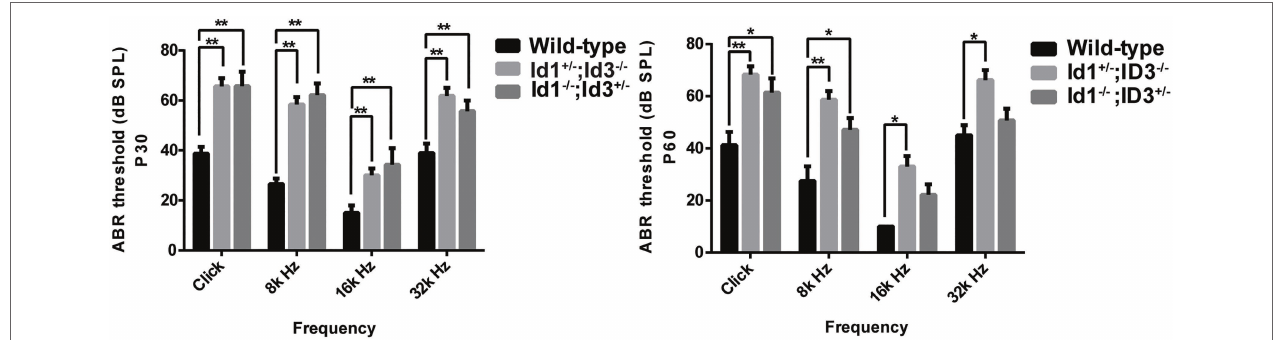
FIGURE 1 | Comparison of the mean auditory brainstem response (ABR) thresholds of right ears from age-matched littermate control mice, Id1 − / − ; Id3 +/ − and Id1 +/ − ; Id3 − / − mice at ages P30 and P60. The results indicated that at P30, the mean ABR thresholds at any stimulus frequencies in the Id1 − / − ; Id3 +/ − ( n = 41) and Id1 +/ − ; Id3 − / − ( n = 14) mice were significantly higher than those of the controls ( n = 21; p < 0.01). At P60, ABR thresholds at all stimulus frequencies in the Id1 − / − ; Id3 +/ − mice ( n = 35) were significantly higher than those of the controls ( n = 8; p < 0.01), and ABR thresholds at Click and 8 k Hz in the Id1 +/ − ; Id3 − / − mice ( n = 14) were significantly higher than those of the controls ( p < 0.05). The error bar indicates SD from the mean of each group. * p < 0.05; ** p <